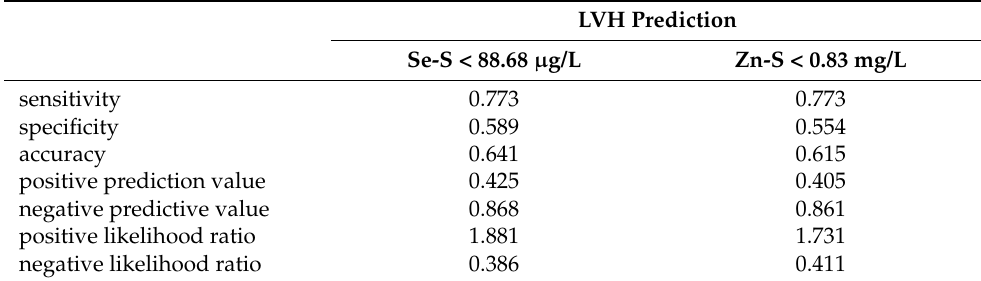
Table 6. Sensitivity and specificity of serum selenium concentration and serum zinc concentration as predictors of left ventricular